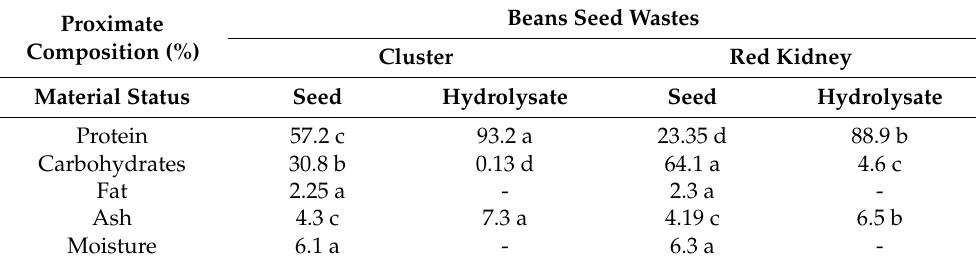
Table 1. Approximate analysis of seed wastes and protein hydrolysate of cluster and red kidney